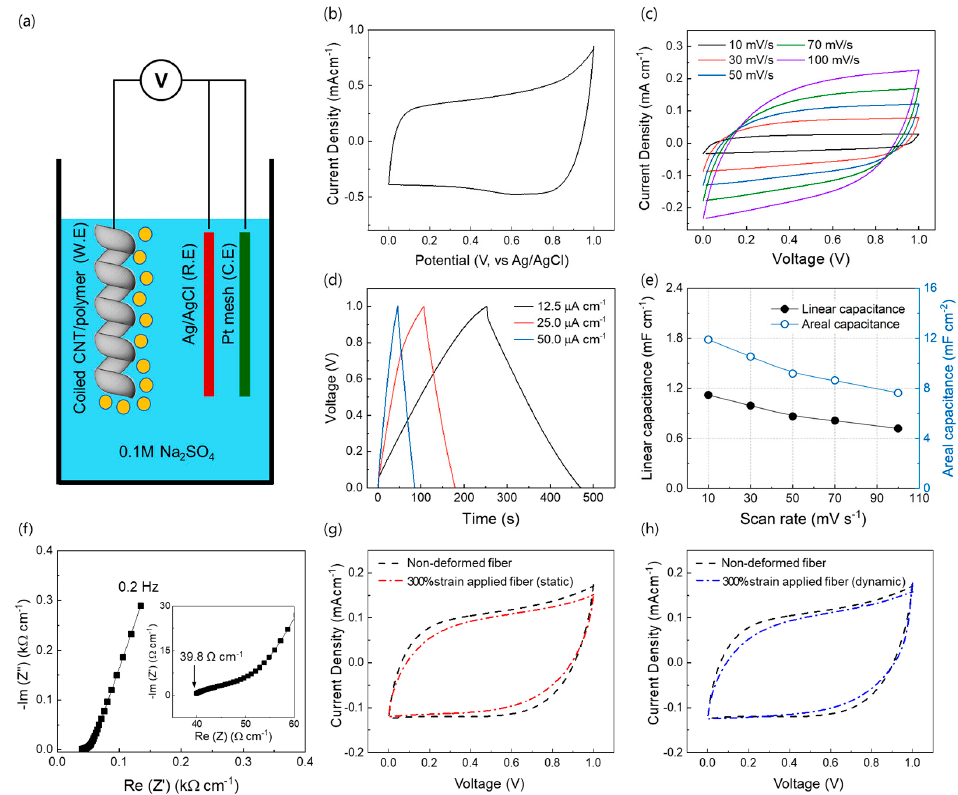
Figure 4. Electrochemical double layer (EDL) charge storage performance of coiled CNT/polymer fiber and capacitance retention during fiber stretching. ( a ) Schematic of the three-electrode system for measurement of the capacitance of coiled CNT/polymer fiber sensor (i.e., the working electrode); Ag/AgCl and Pt mesh were used as reference and counter electrodes in 0.1M Na 2 SO 4